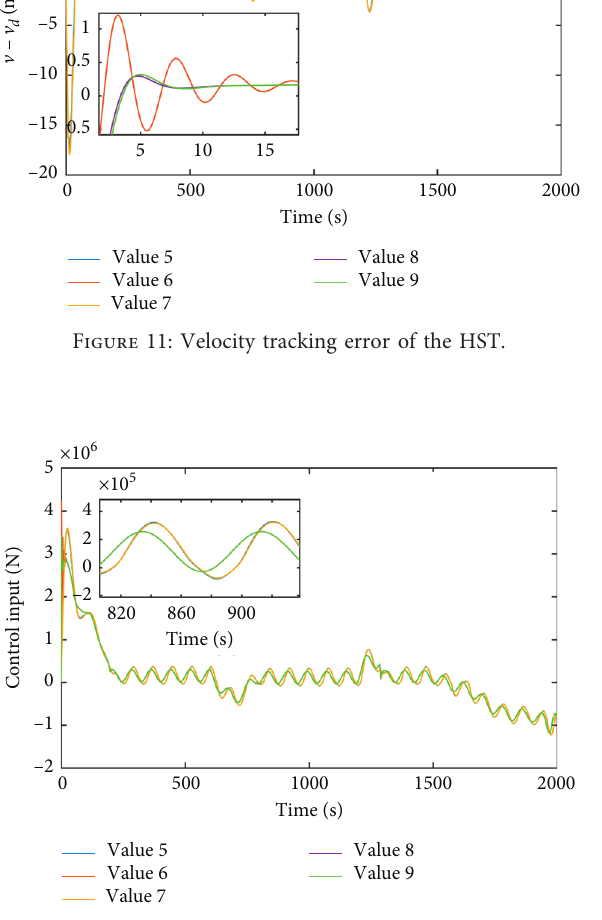
Figure 12: Control